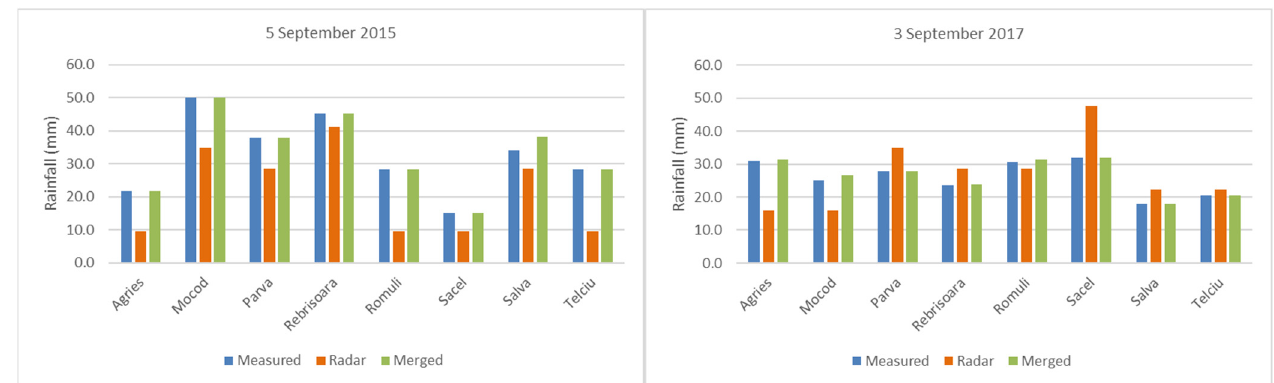
Figure 6. Frontal system comparative rainfall amounts.